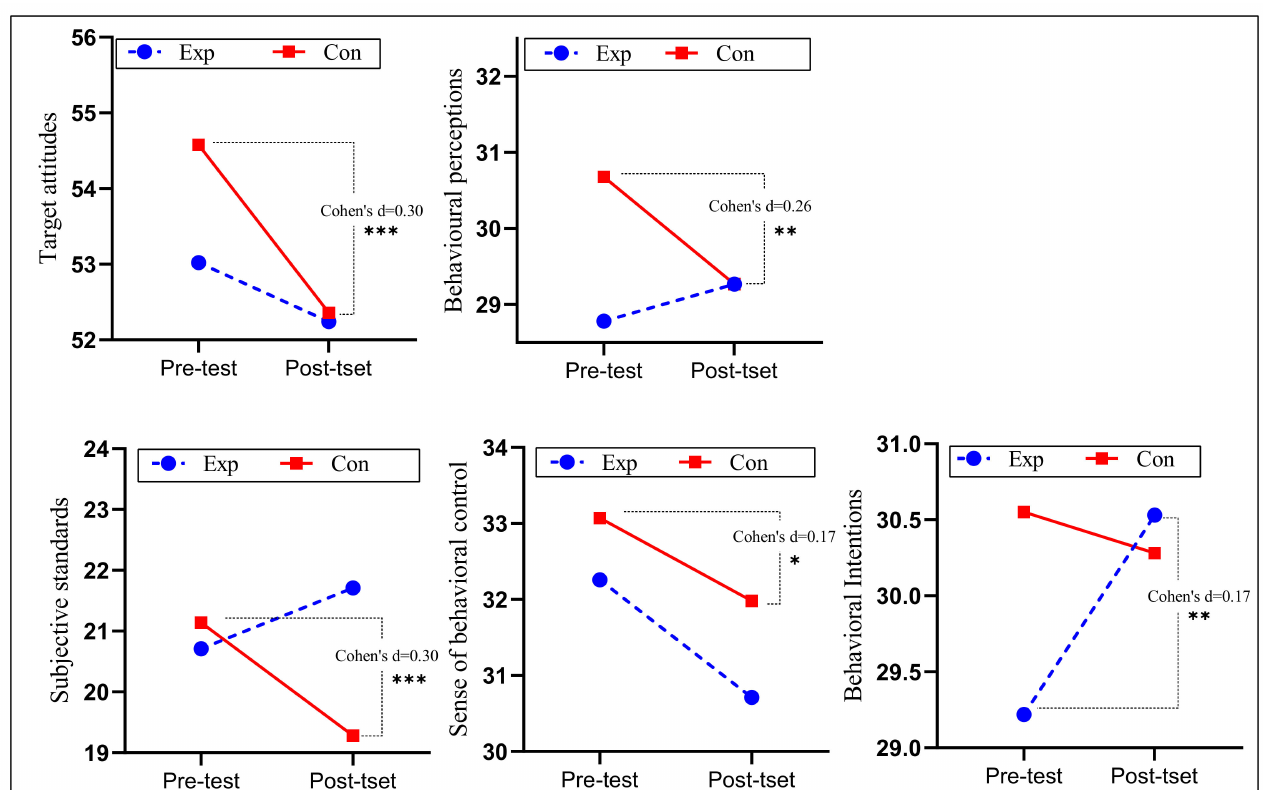
Figure 7. Descriptive statistics and within-group variations of means of exercise attitude. *: p < 0.05; **: p < 0.01; ***: p < 0.001.